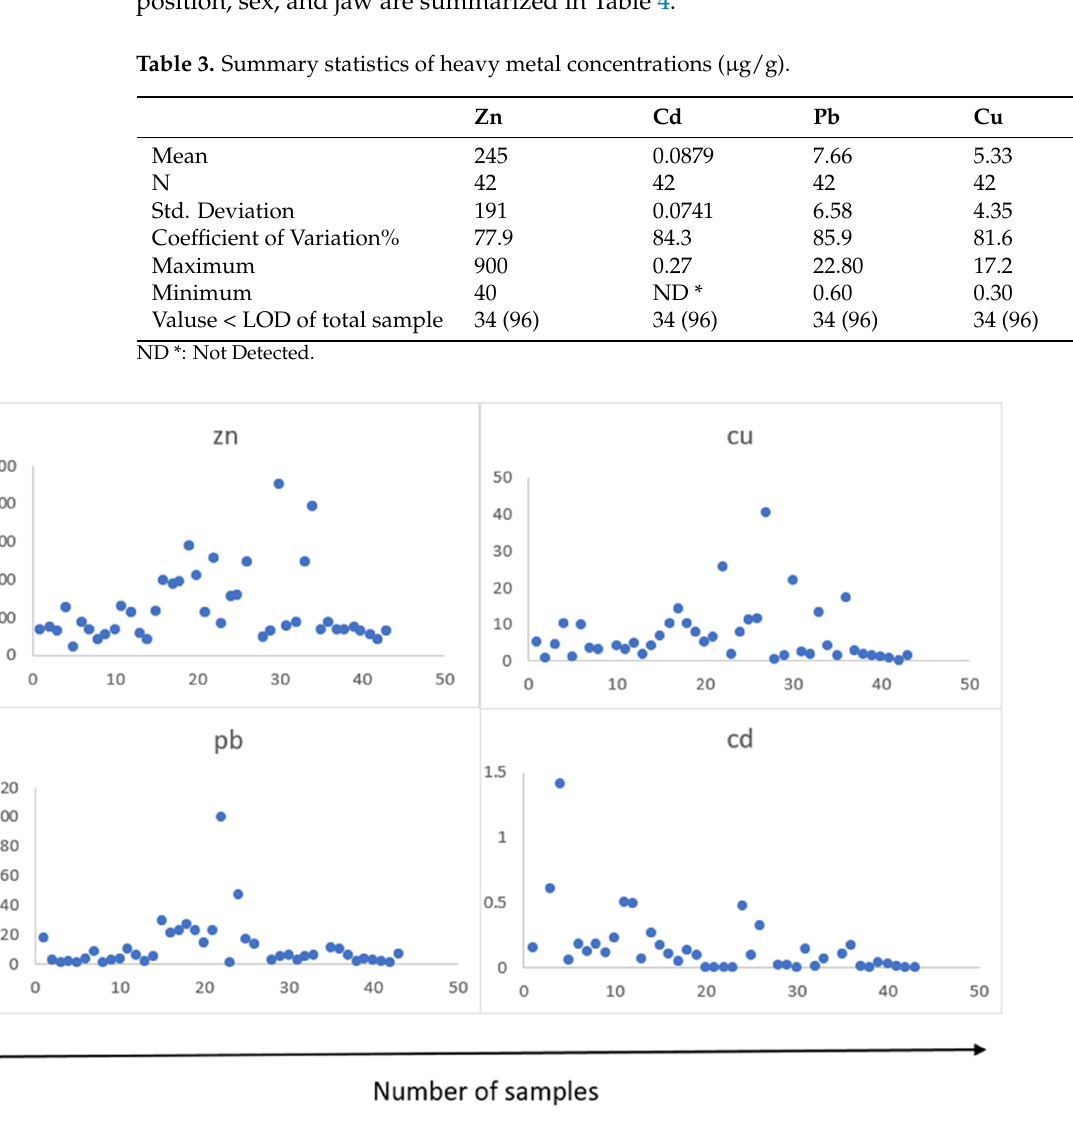
Figure 2. The distribution of zinc, Cd, Pb, and Cu concentrations in each numbered sample after three replications.